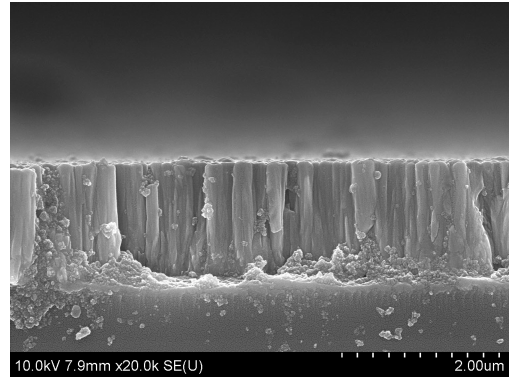
Figure 10. SEM picture of the cross-section view of the ZnO films.